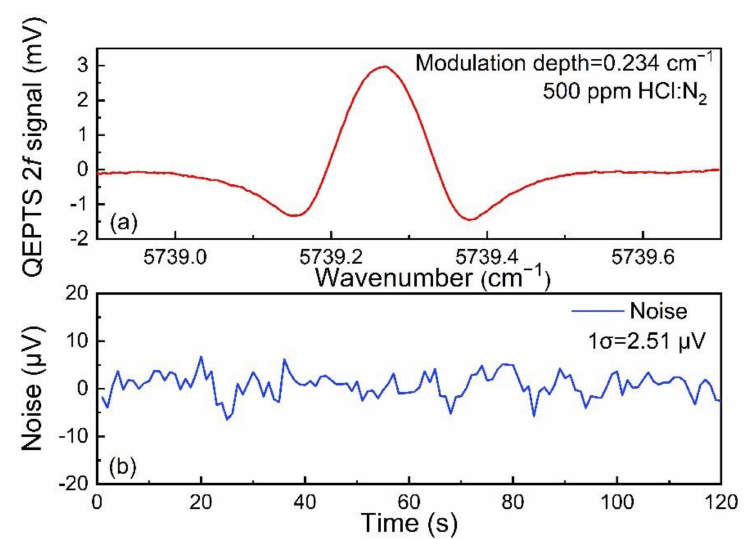
Figure 5. The 2 f signal and noise for the HCl-QEPTS sensor. ( a ) QEPTS 2 f signal with laser power of 8 mW; ( b ) noise level determination when pure N 2 was